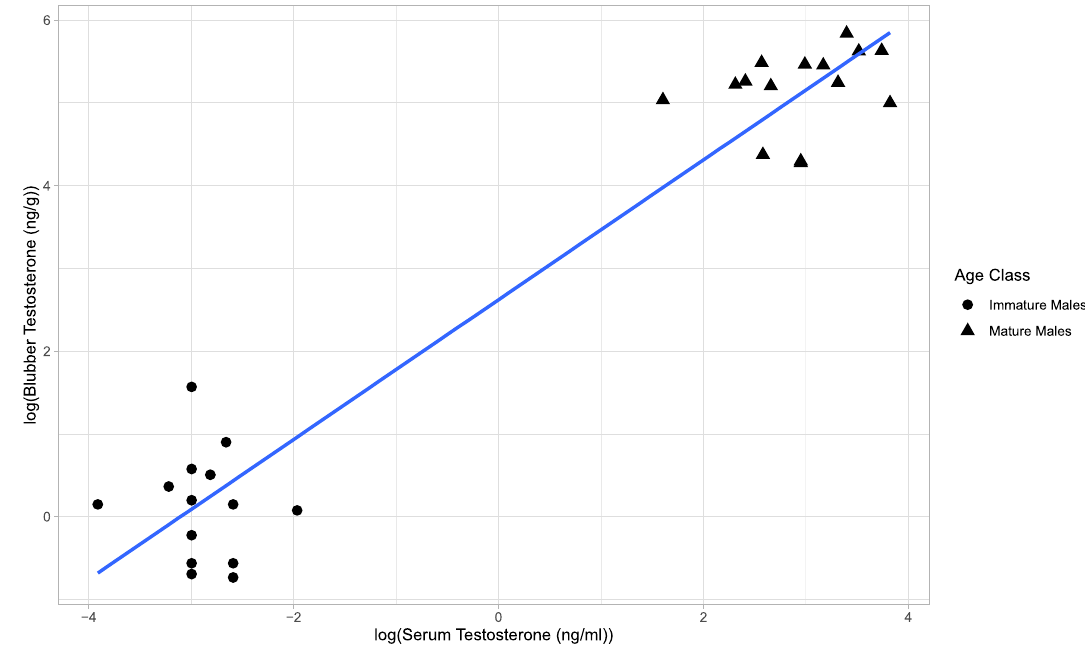
Figure 1. Relationship of blubber testosterone concentration (ng/g lipid mass) to serum testosterone concentration (ng/ml) for mature and immature male T. truncatus from Sarasota Bay, FL (r 2 = 0.932, p < 2.2 × 10 – 16 , y = 0.845*x + 2.618).